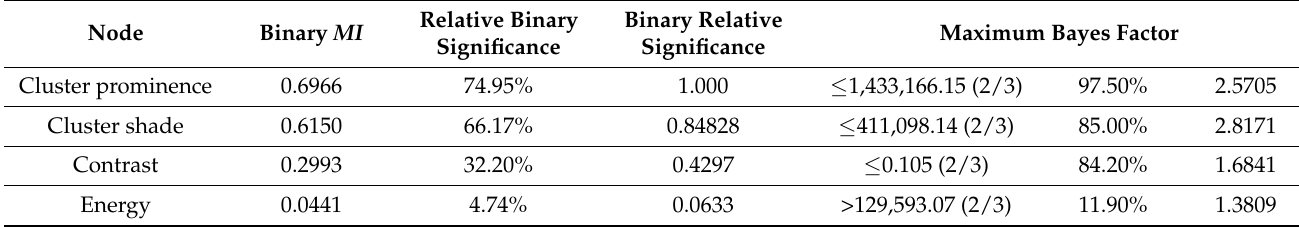
(cid:16) (cid:17) 2 3